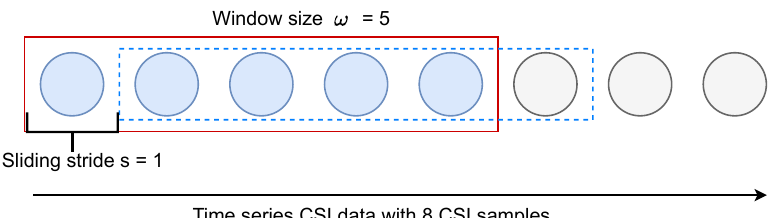
Figure 4. An example of data expansion using sliding